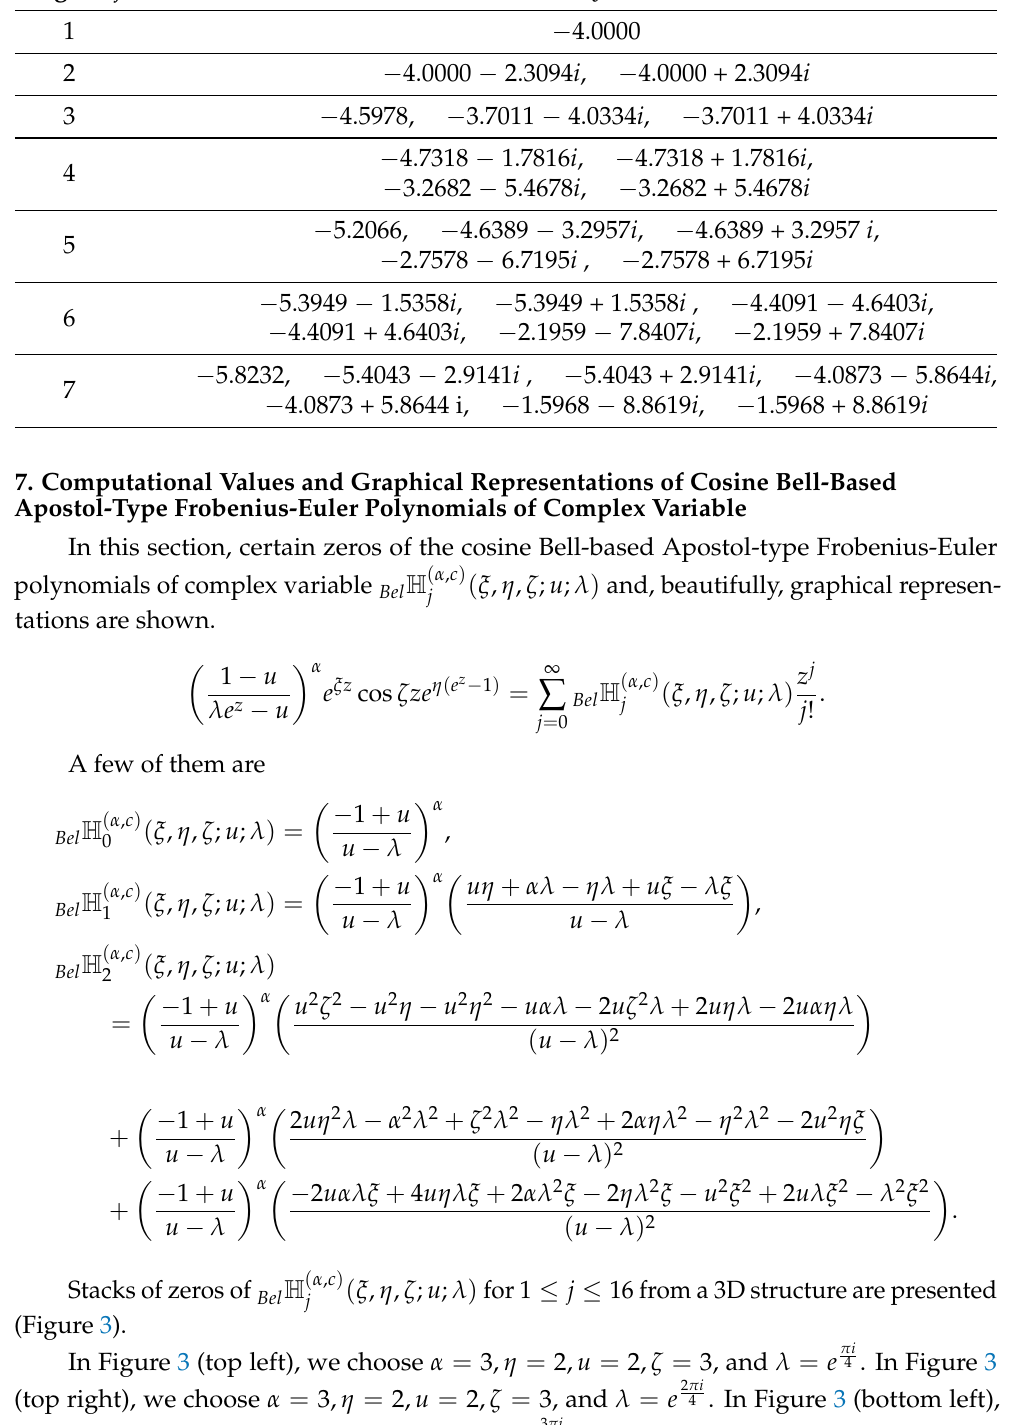
Table 1. Approximate solutions of Bel H